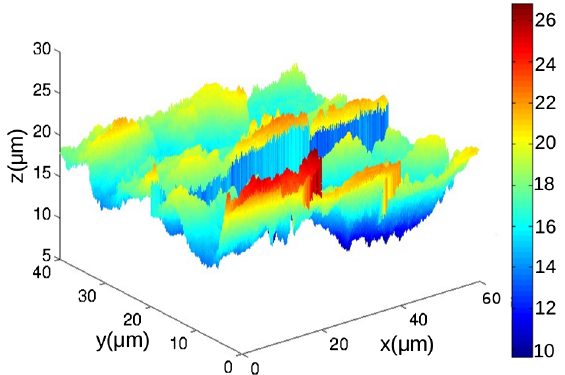
FIG. 11. Merge of 6 adjacent images scans for aluminum sample #1.